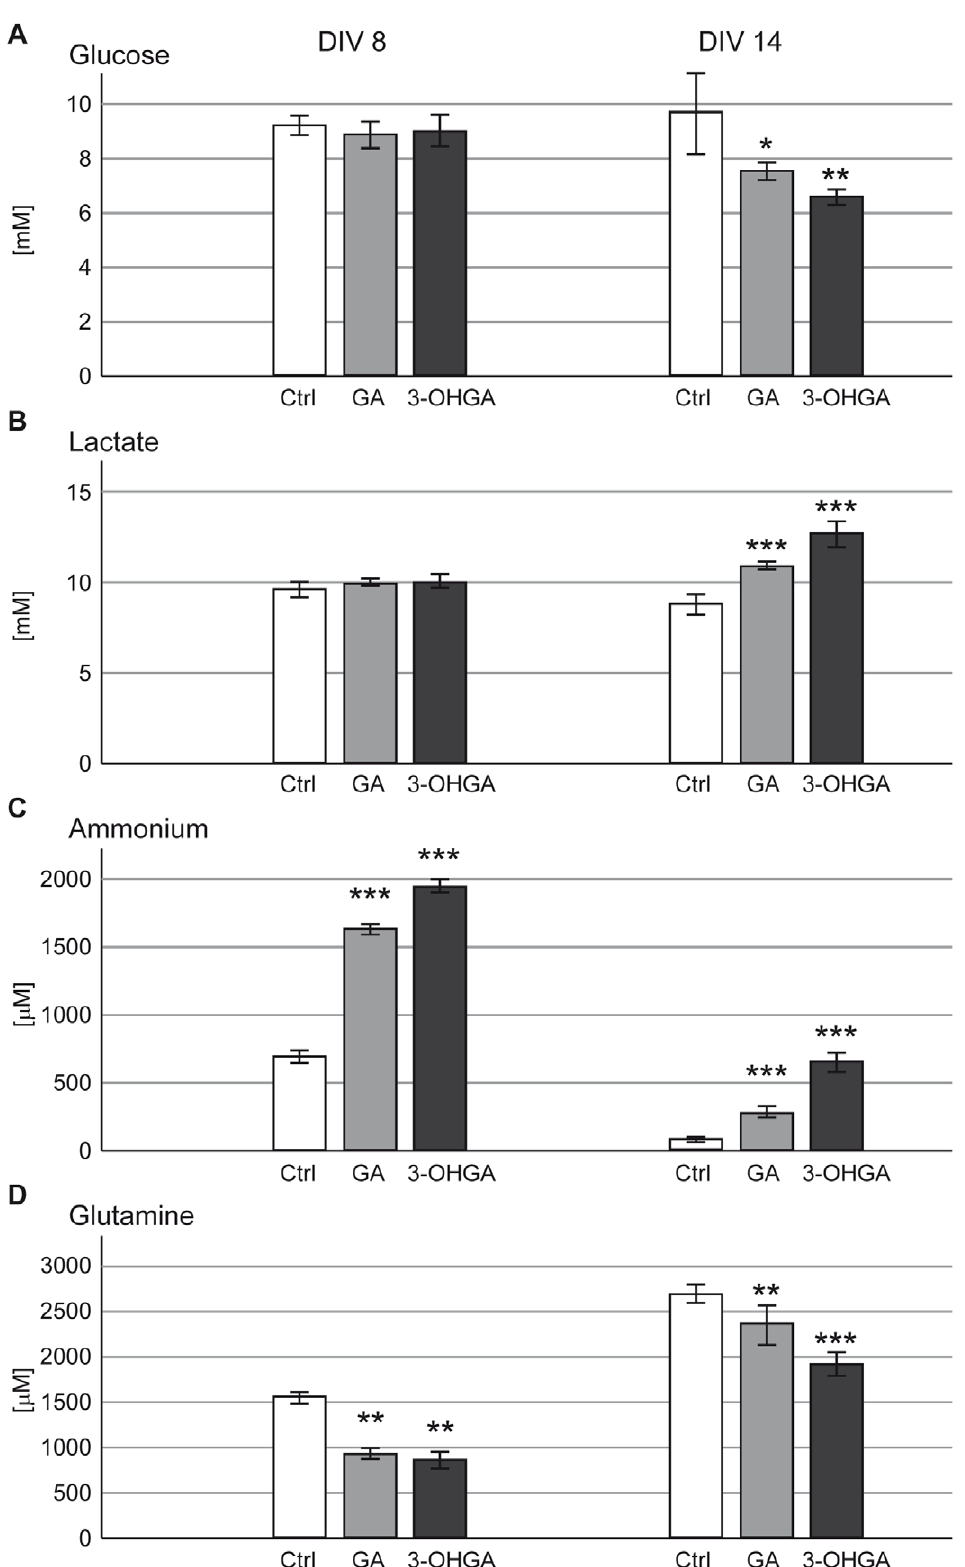
Figure 5. Effects of GA and 3-OHGA on biochemical parameters measured in culture medium. Glucose (A), lactate (B), ammonium (C) and glutamine (D) were measured in the medium of cultures treated with protocols A (DIV 8) or B (DIV 14). Mean 6 SD of 7 replicate cultures assessed by Student’s t -test; *p , 0.05, **p , 0.01, *** p , 0.001.